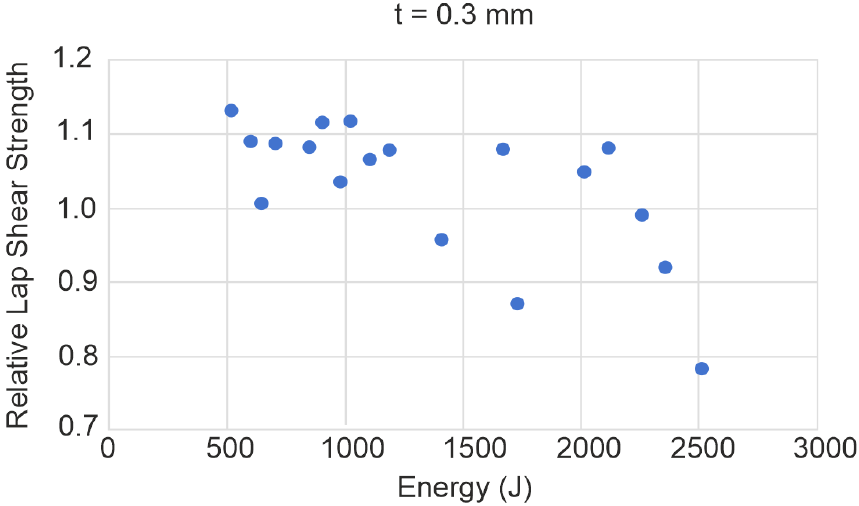
Figure 18. Lap shear strength vs. energy for t = 0.3 mm.